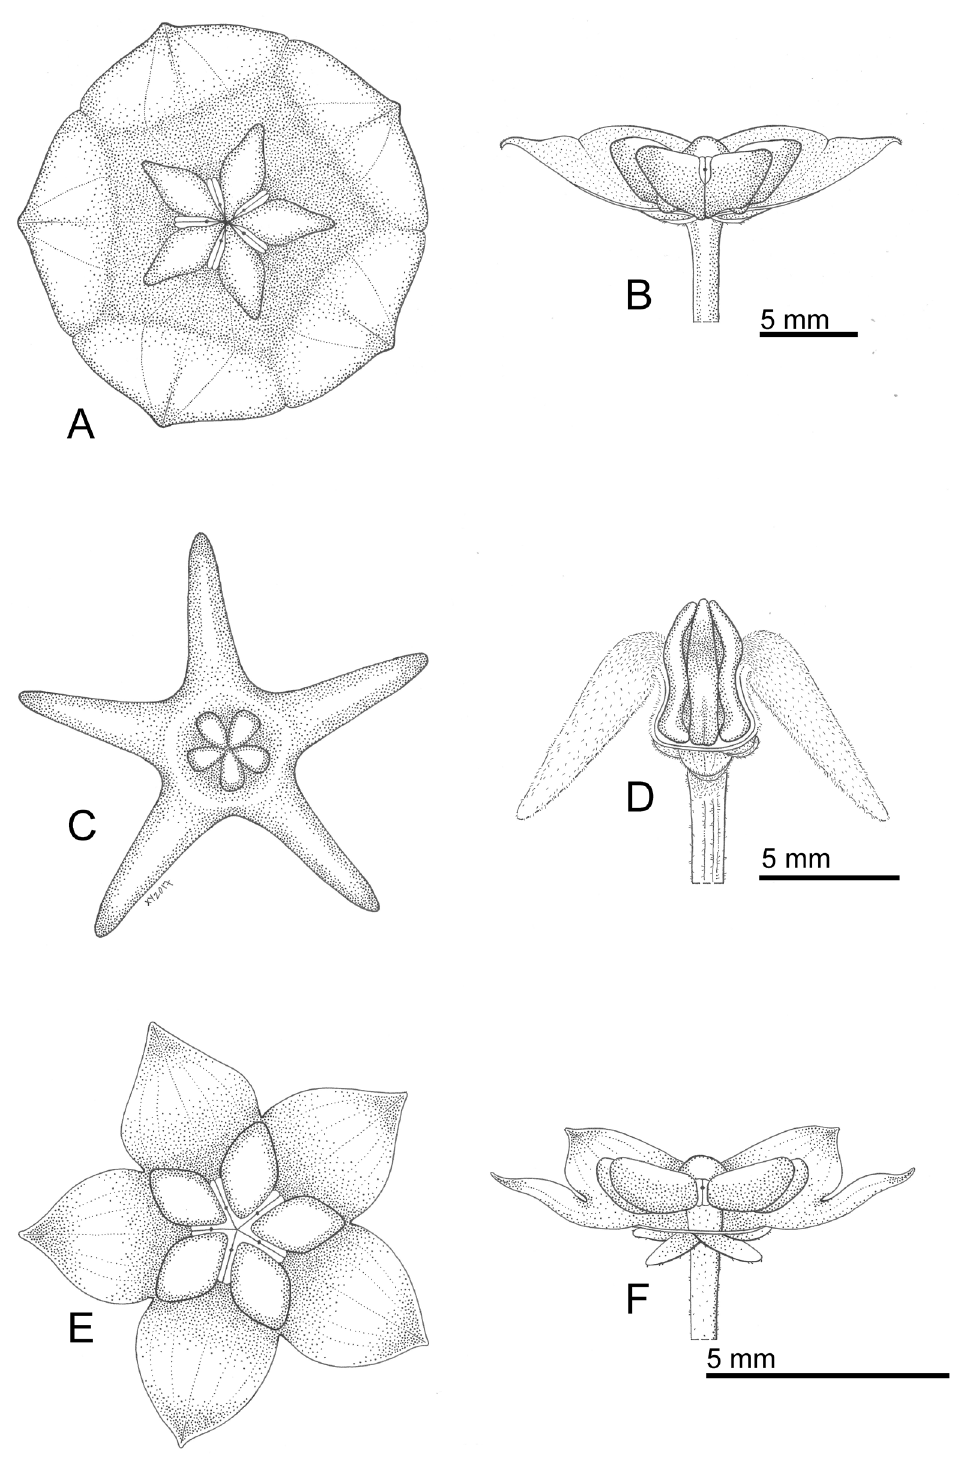
Fig. 1. Flowers. A , C , E . Top view of the flower. B , D , F . Side view of the flower, with part of corolla removed. A – B . H. danumensis subsp. amarii S.Rahayu & Rodda subsp. nov.